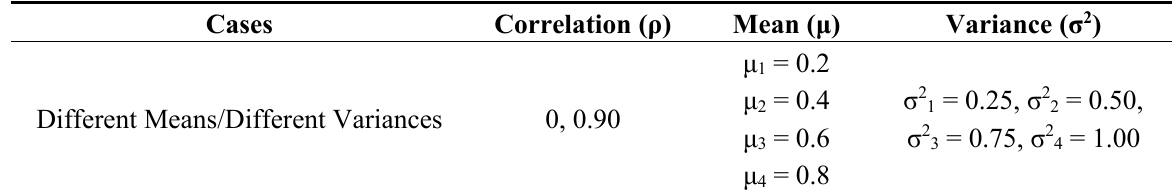
Table 4. Test cases with various demand statistical